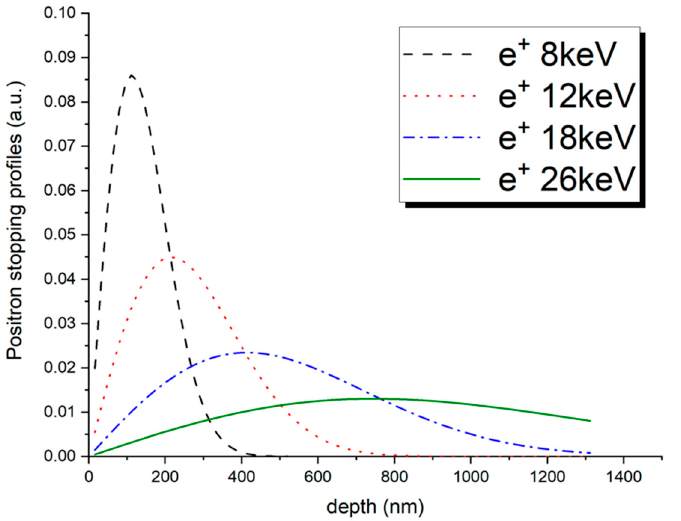
Figure 1. Positron stopping profiles in Fe, corresponding to different beam energies.